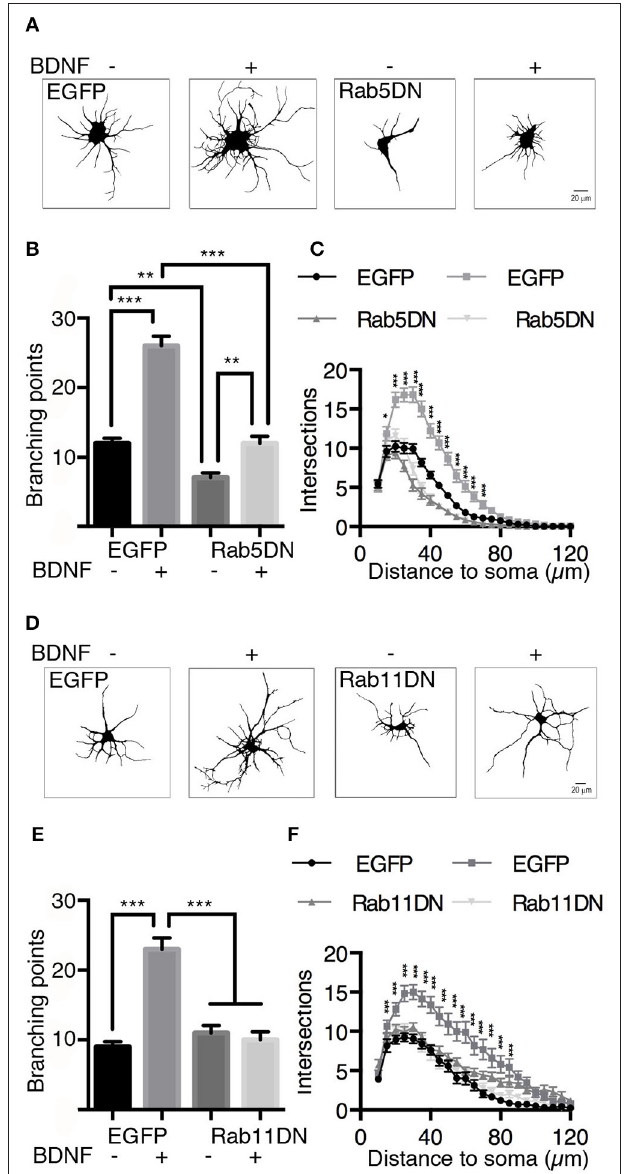
FIGURE 9 | The expression of dominant-negative mutants of Rab5 (Rab5DN) decreases BDNF-induced dendritic branching in hippocampal neurons. (A) Representative image of hippocampal neurons (7 DIV) transduced with adenovirus EGFP (in A at the left) or with a dominant-negative mutant of Rab5 fused to EGFP (Rab5DN in A at the right) and stimulated with BDNF for 48h. After fixation, the neurons were labeled with anti-MAP2, observed by fluorescence microscopy and subjected to morphometric analysis. (B) Sholl analysis of the arborization profiles of neurons expressing EGFP and Rab5DN-EGFP in the presence or absence of BDNF. (C) Quantification of the branching points of neurons that overexpressed Rab5DN or EGFP and exposed to BDNF. N = 27–34 neurons from 3 different experiments. (D) Representative image of hippocampal neurons (7 DIV) that were transduced with adenovirus EGFP (in D at the left) or a dominant-negative mutant of Rab11 fused to EGFP (Rab11DN in A at the right) and stimulated with BDNF for 48h. After fixation, the neurons were labeled with anti-MAP2, observed by fluorescence microscopy and subjected to morphometric analysis. (E) Sholl